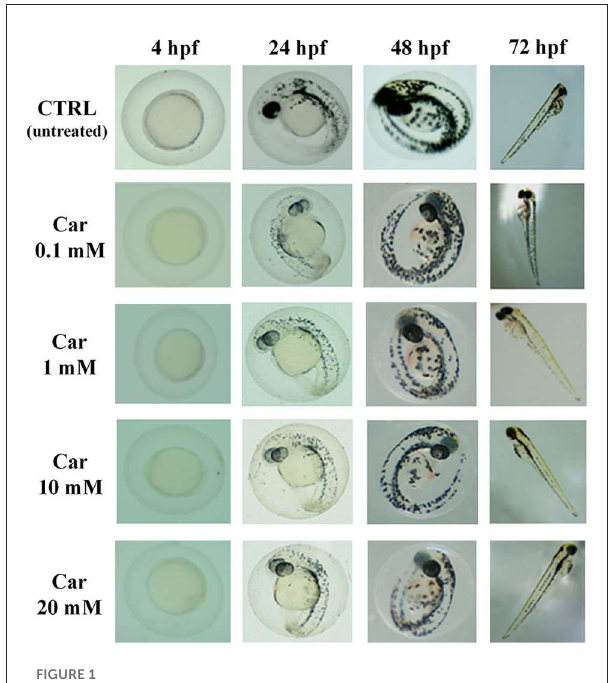
FIGURE1 Effects of increasing concentrations of carnosine (0.1, 1, 10, and 20mM) on the phenotypes of both embryos and larvae at different (4, 24, 48, and 72) hpf. Car, carnosine.